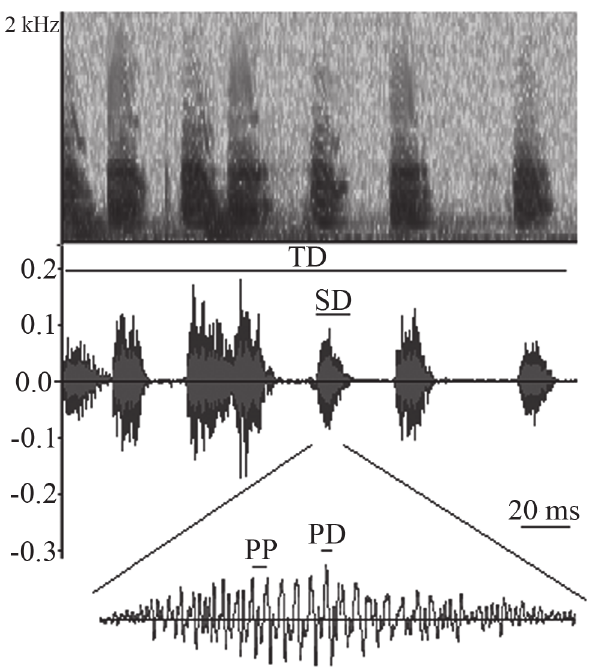
Fig. 1. Sonogram (top) and oscillogram (below) of pectoral sounds illustrating sound characteristics measured. TD = train durations; SD = sound duration; PP = pulse period; PD = pulse durations.